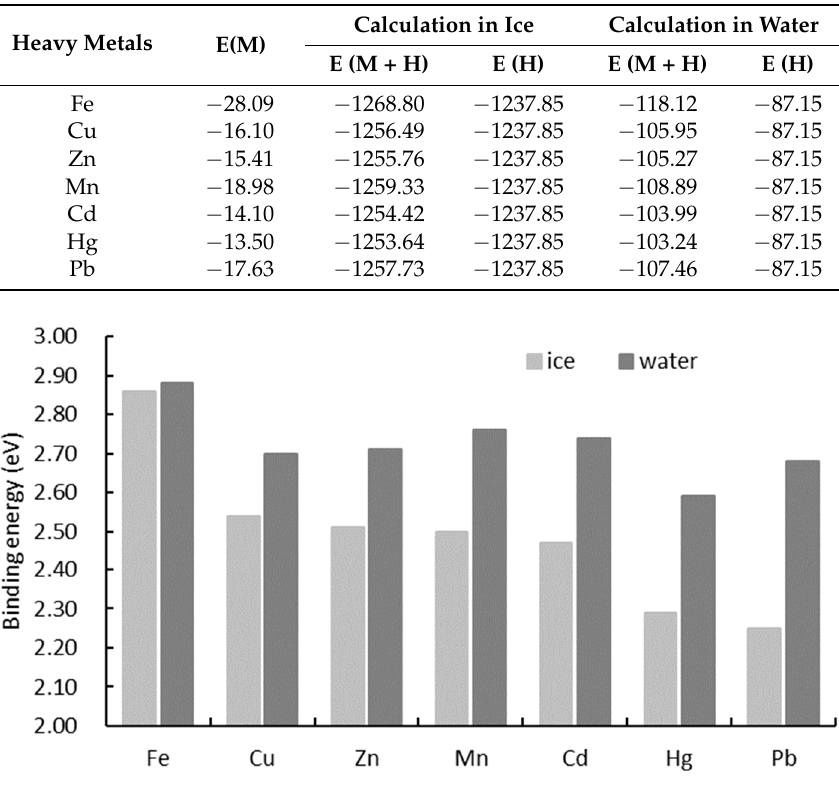
Table 3. Binding energy calculation process (eV).